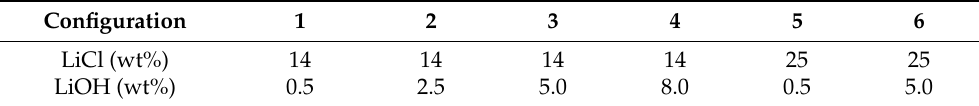
Table 3. Initial LiCl and LiOH concentrations in solution for lithium ion transport number